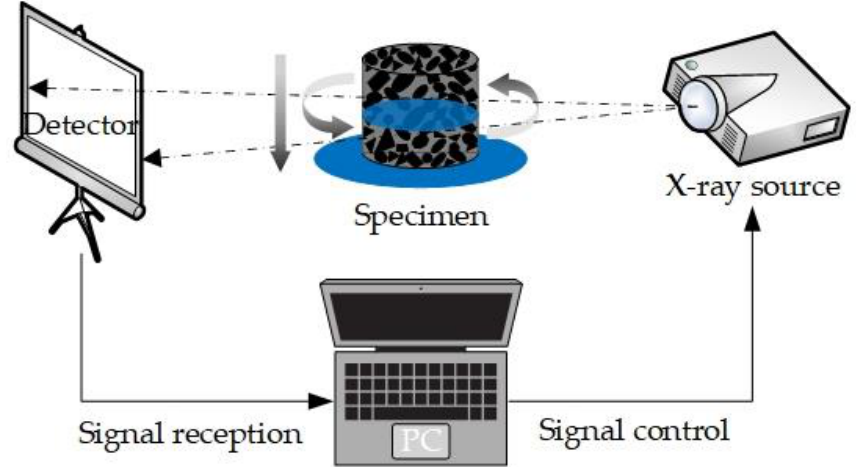
Figure 3. The working schematic diagram of X-ray CT scanning system.